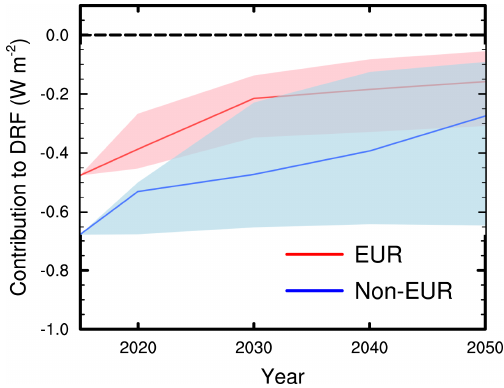
Figure 11. Time series (2015–2050) of estimated annual mean sul- fate DRF over Europe contributed by European and non-European emissions. Lines and areas represent median values and minimum- to-maximum ranges of the estimated sulfate DRF from eight SSP scenarios, including SSP1-1.9, SSP1-2.6, SSP2-4.5, SSP3-7.0, SSP4-3.4, SSP4-6.0, SSP5-3.4, and SSP5-8.5. Future DRF of sul- fate aerosol over Europe is estimated by scaling historical mean (1980–2018) sulfate DRF using the ratio of SSPs future SO 2 emis- sions to historical emissions and assuming a linear response of DRF to regional